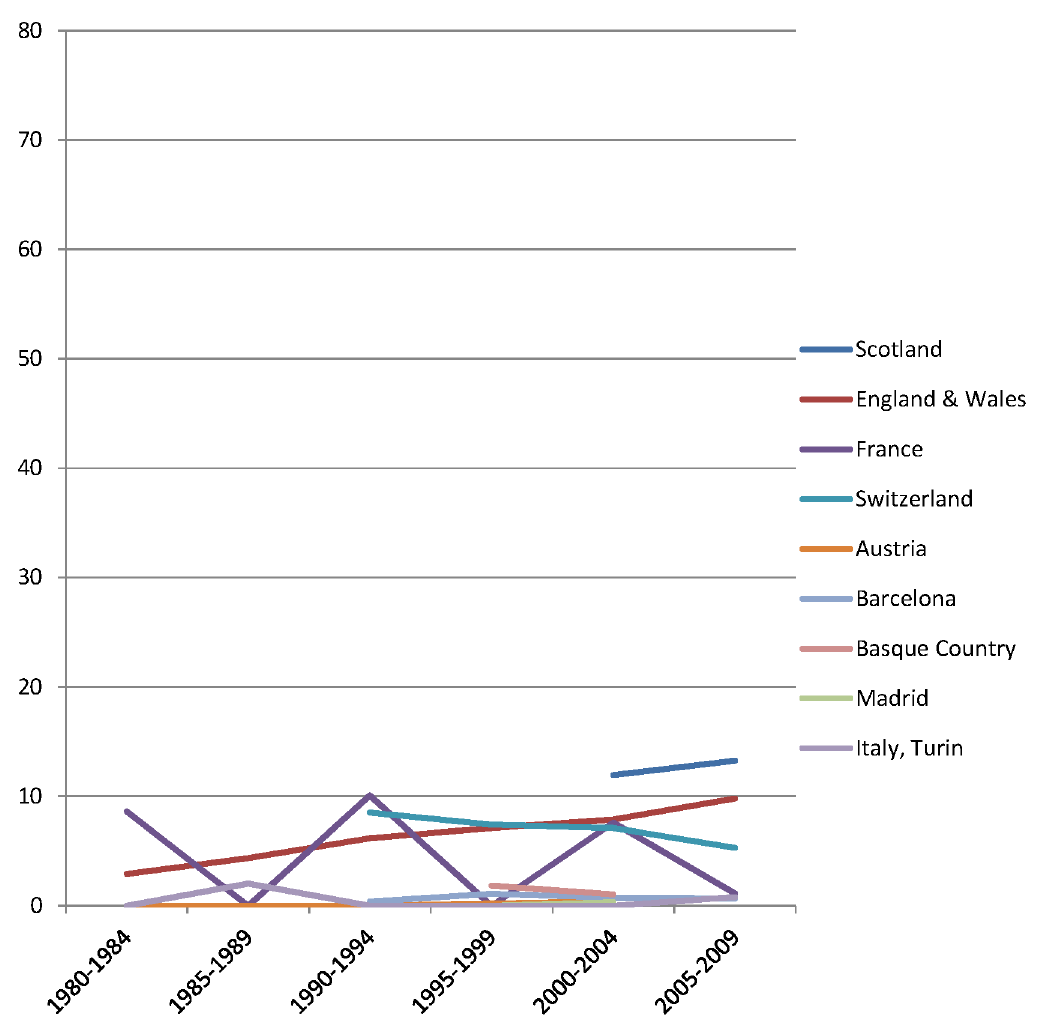
Fig 9. Trends in age-adjusted mortality from alcohol-related causes among women aged 35 – 79 y in the high education group in Western and Southern European countries/regions, ca. 1980 – 2010, by country/region. The y- axis shows age-adjusted alcohol-related mortality in deaths per 100,000